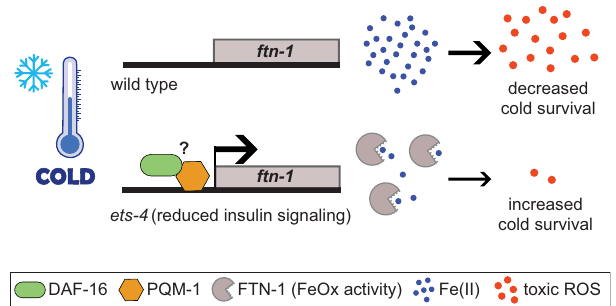
Fig. 10 | A model for FTN-1/FTH1-dependent cold resistance. FTN-1, which at standardgrowthconditionsisweaklyexpressed,isupregulatedincold-treated ets- 4 mutants. This induction requires a combined action of DAF-16 and PQM-1 TFs, whereDAF-16couldberecruited to ftn-1 promotorindirectly,possiblythroughthe interaction with PQM-1. Once expressed, FTN-1, thanks to its ferroxidase (FeOx) activity, converts toxic ferrous iron to its ferric form. By doing so, FTN-1 helps to reduce the levels of cytotoxic reactive oxygen species (ROS), whose production is catalyzed by ferrous iron, thus facilitating cold survival. Overexpression of the mammalian counterpart of FTN-1, FTH1, has a similar effect on cold-exposed neu- rons(notshowninthemodel),suggestingthatferroxidase-activeferritinfunctions as an endogenous antioxidant and, by doing so, promotes cold